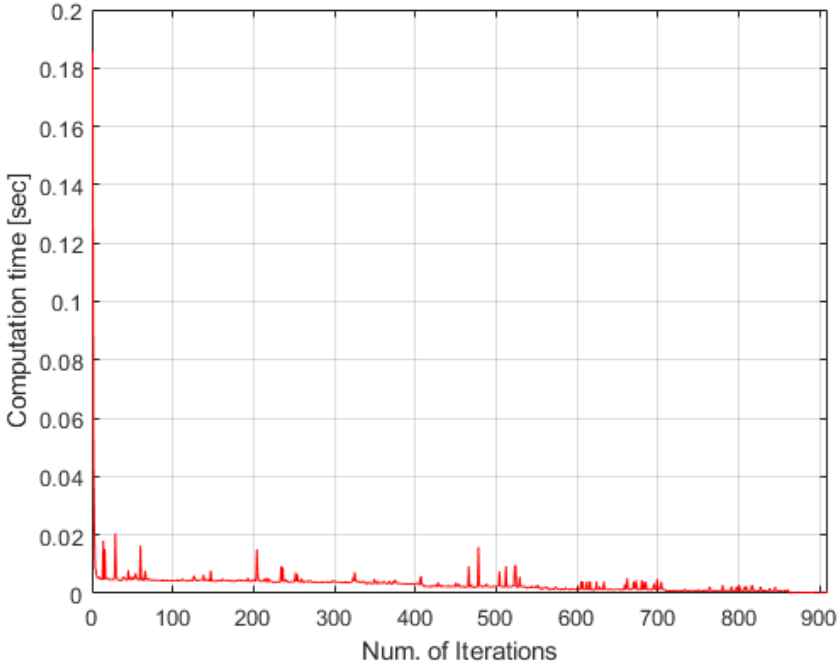
Figure 2. Computational time of TACTAR for a simple case applying a modified time-discounted reward scheme.